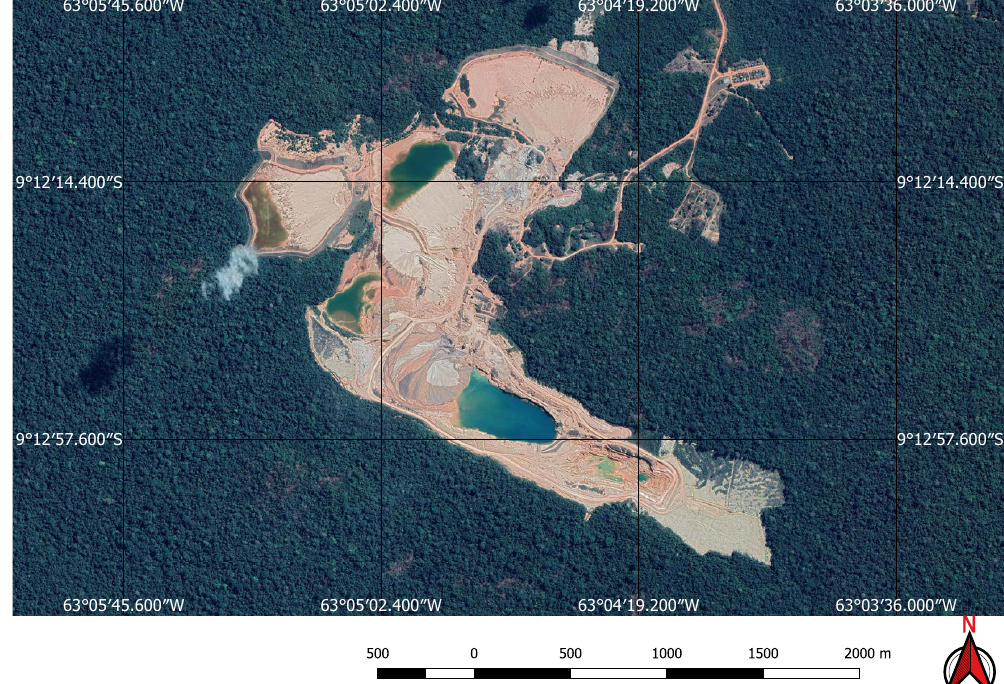
Figure 3. High resolution Google Earth image showing mine and associated dam.